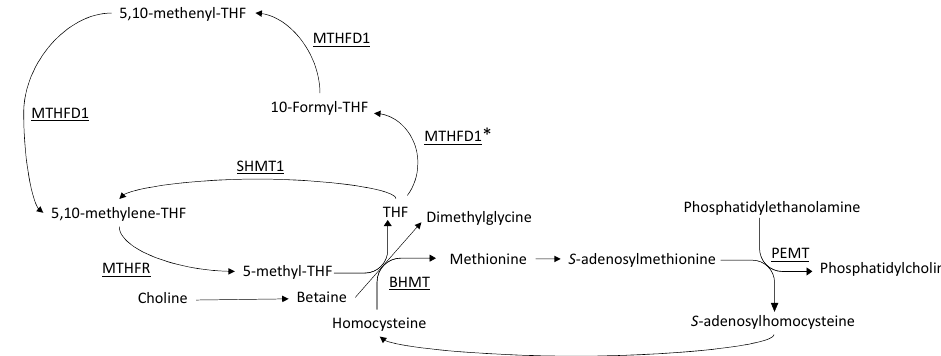
Figure 1. The role of one-carbon metabolism in phosphatidylcholine synthesis through the phosphatidylethanolamine N -methyltransferase (PEMT) pathway. Key enzymes are underlined. BHMT: betaine-homocysteine S -methyltransferase; MTHFD1: methylenetetrahydrofolate dehydrogenase; MTHFR: methylenetetrahydrofolate reductase; PEMT: phosphatidylethanolamine N -methyltransferase; SHMT1: serine hydroxymethyltransferase 1. * Denotes the domain of the MTHFD1 tri-functional enzyme containing the rs2235226 variant.